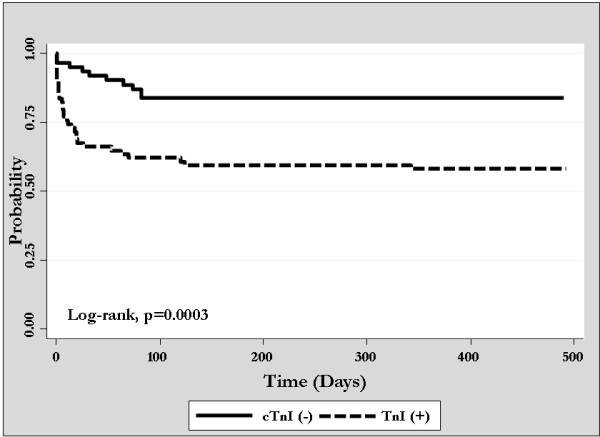
Crude Kaplan-Meier survival stratified by post-operative cTnI status.